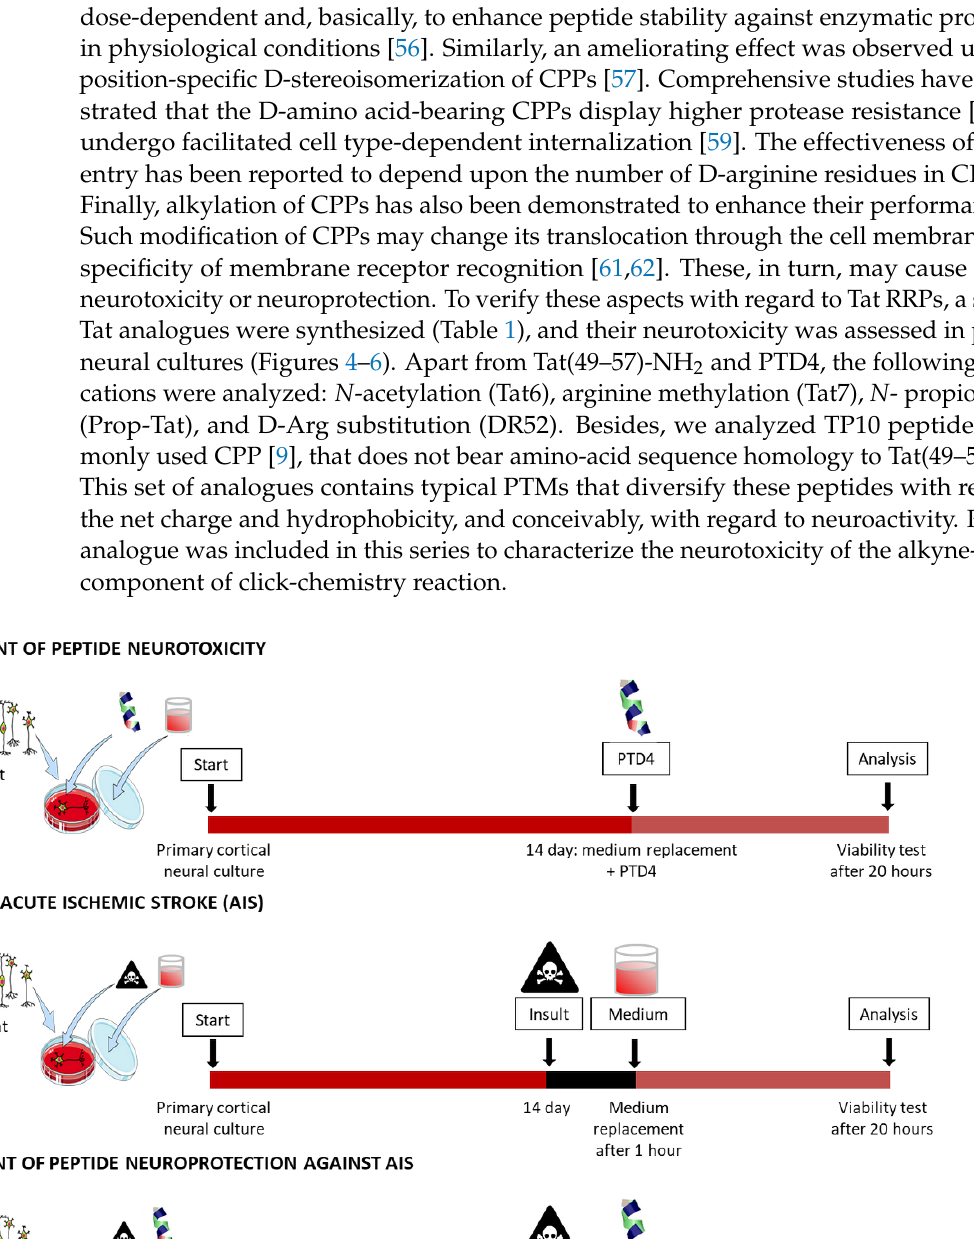
Figure 5. Peptide neurotoxicity in the cortical culture. Non-insulted cells were treated as 100% control. Data demonstrate relative measurements to control ± SD. Two-way ANOVA statistics: n = 3; * p < 0.05, ** p < 0.001.